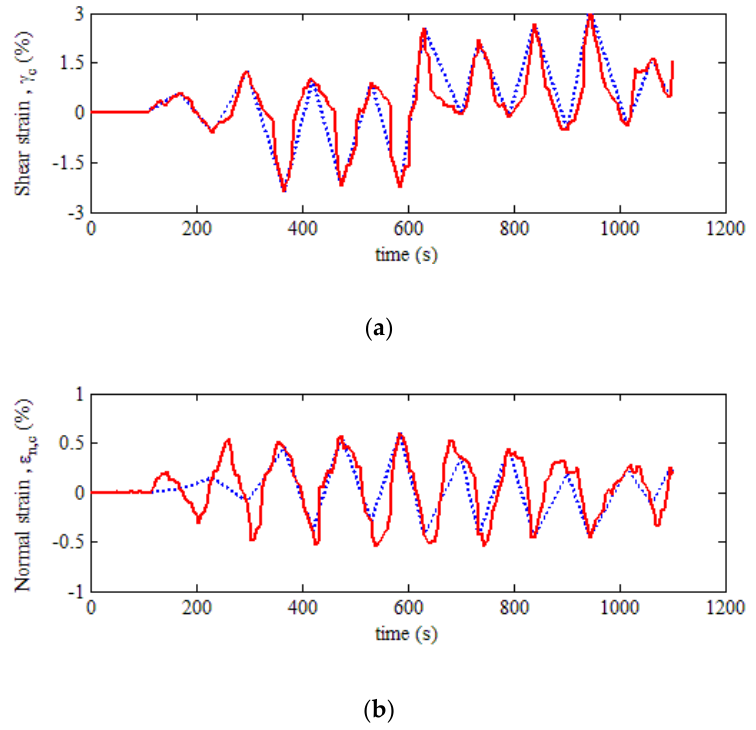
γ are counted γ are counted m m ε Δ and the normal ε Δ and the normal